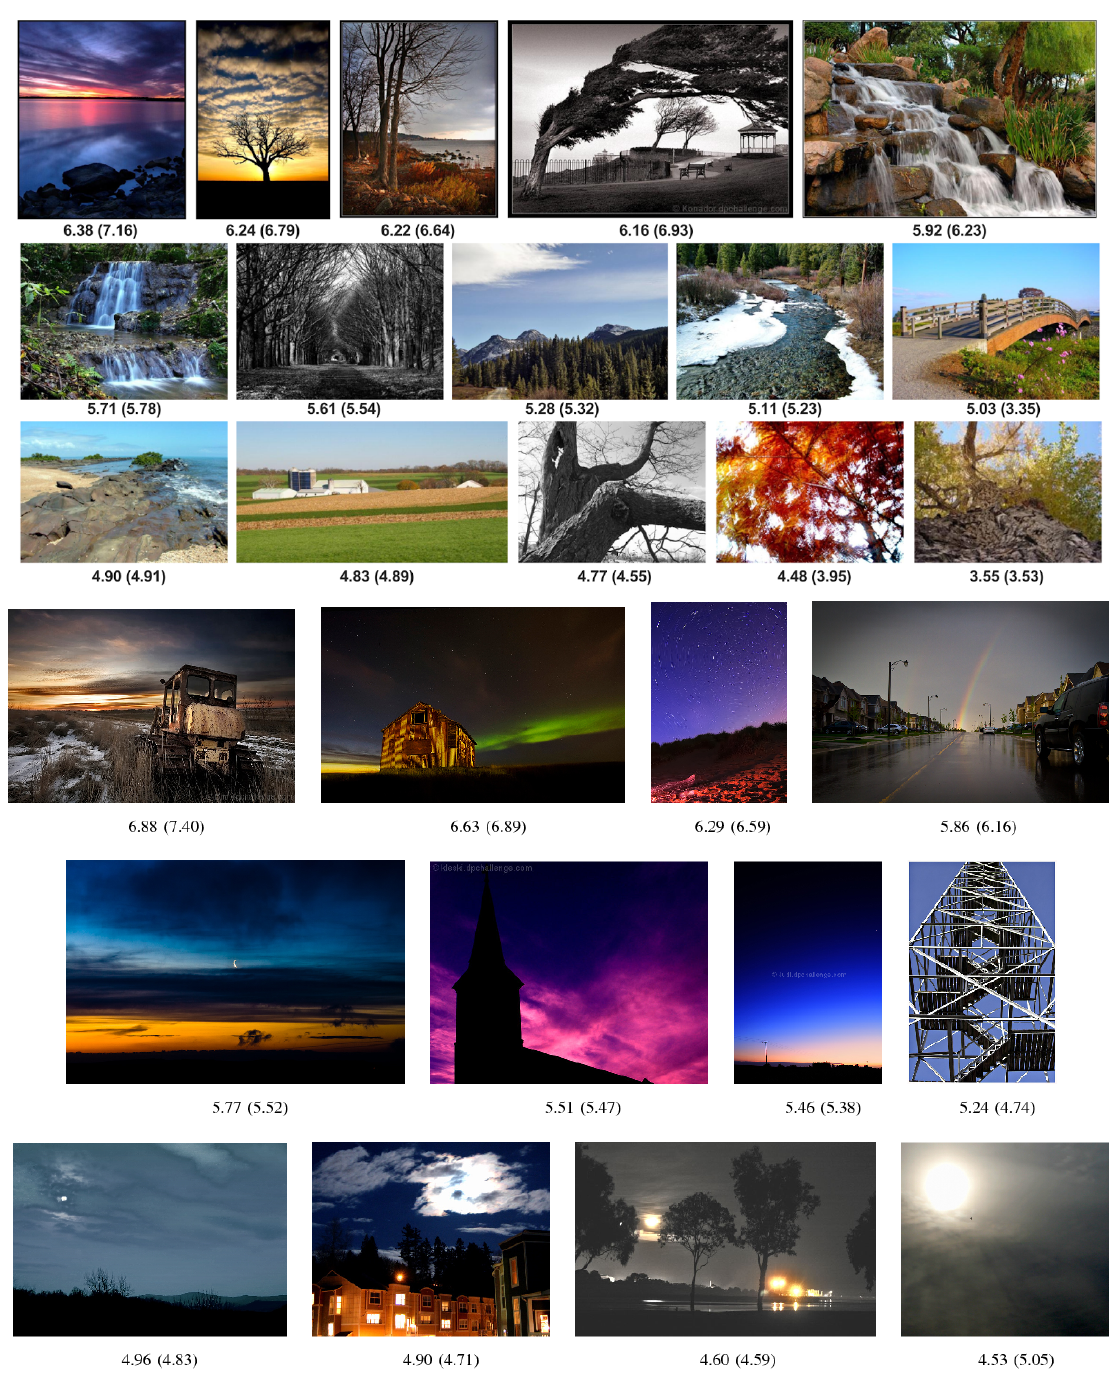
Figure 1. Ranking of some examples, labeled with the “landscape” tag, from the Aesthetic Visual Analysis (AVA) dataset using Neural Image Assessment (NIMA). Predicted NIMA (and ground truth in the brackets) scores are shown below each